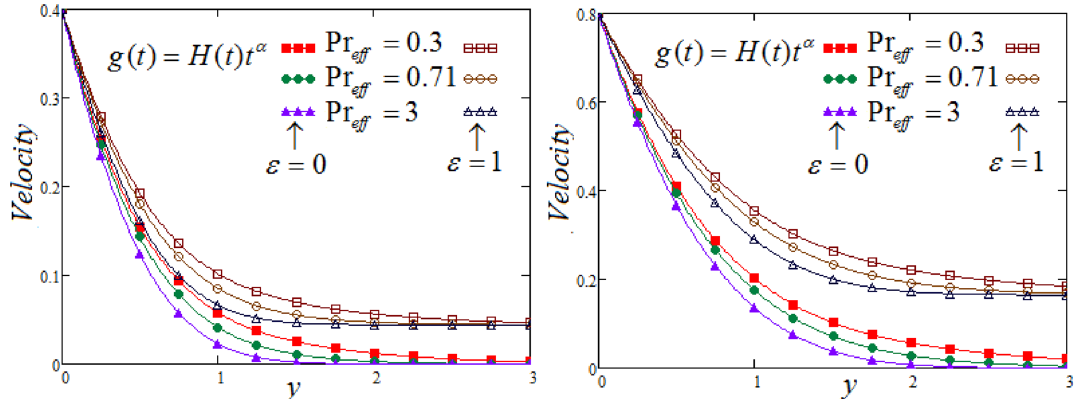
Figure 8. Representation of fluid velocity v ( y , t ) against y for distinct values of Pr eff with N = 2.5, (cid:31) 1 = 0.7, ℘ = π